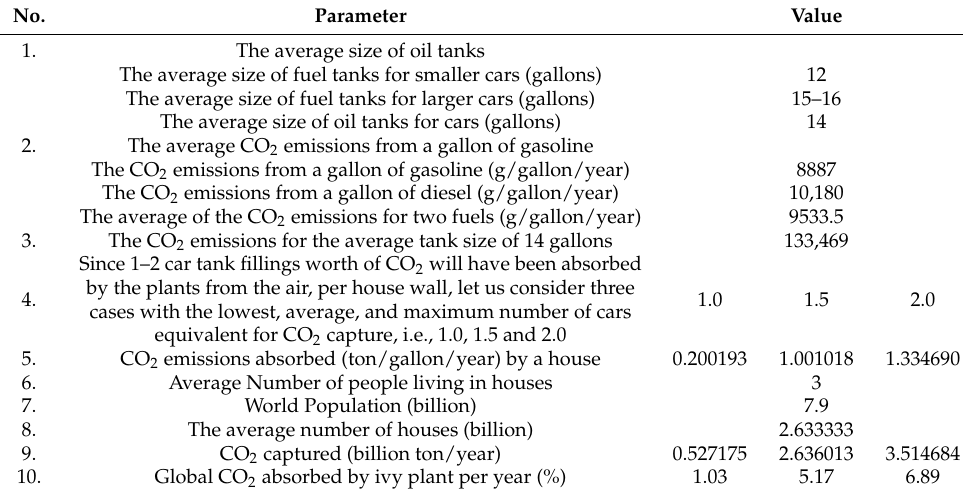
Table 1. Calculating procedure of percentage reduction in the CO 2 emissions to the